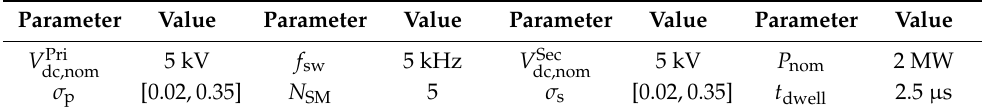
Table 1. Specifications of the simulated dc–dc